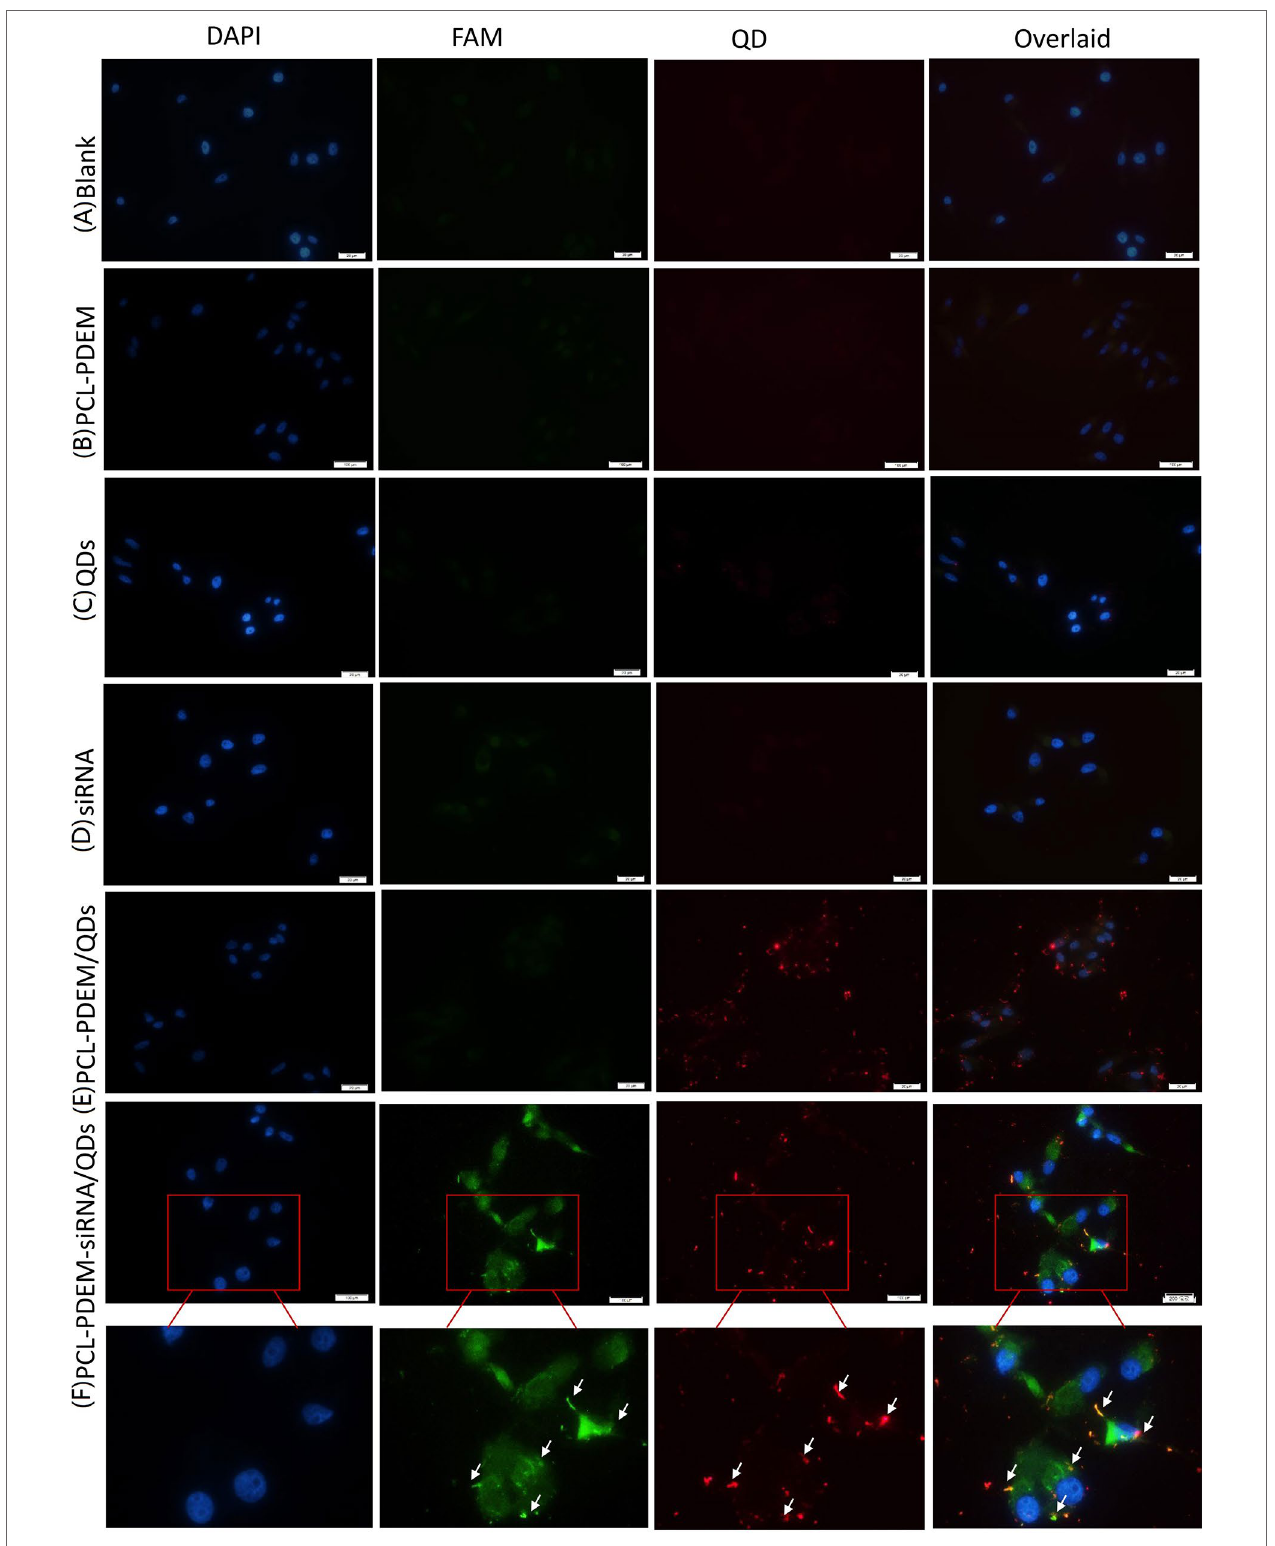
FIGURE 7 | The fluorescence images of cells treated with different nanoformulations for 4 h. (A) Blank, (B) PCL-PDEM, (C) QDs, (D) PCL-PDEM/QDs, (E) siRNA, and (F) PCL-PDEM-siRNA/QDs complex into cell medium. The P/N molar ration in complex is 1:10. Scale bar: 50